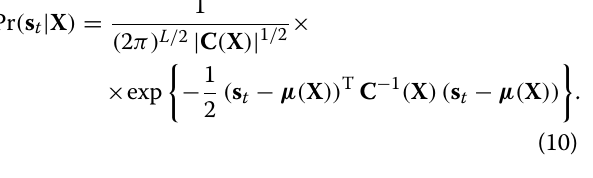
μ ( m ) ( X ) , where (cid:6)μ ( d ) f i , (cid:2) j